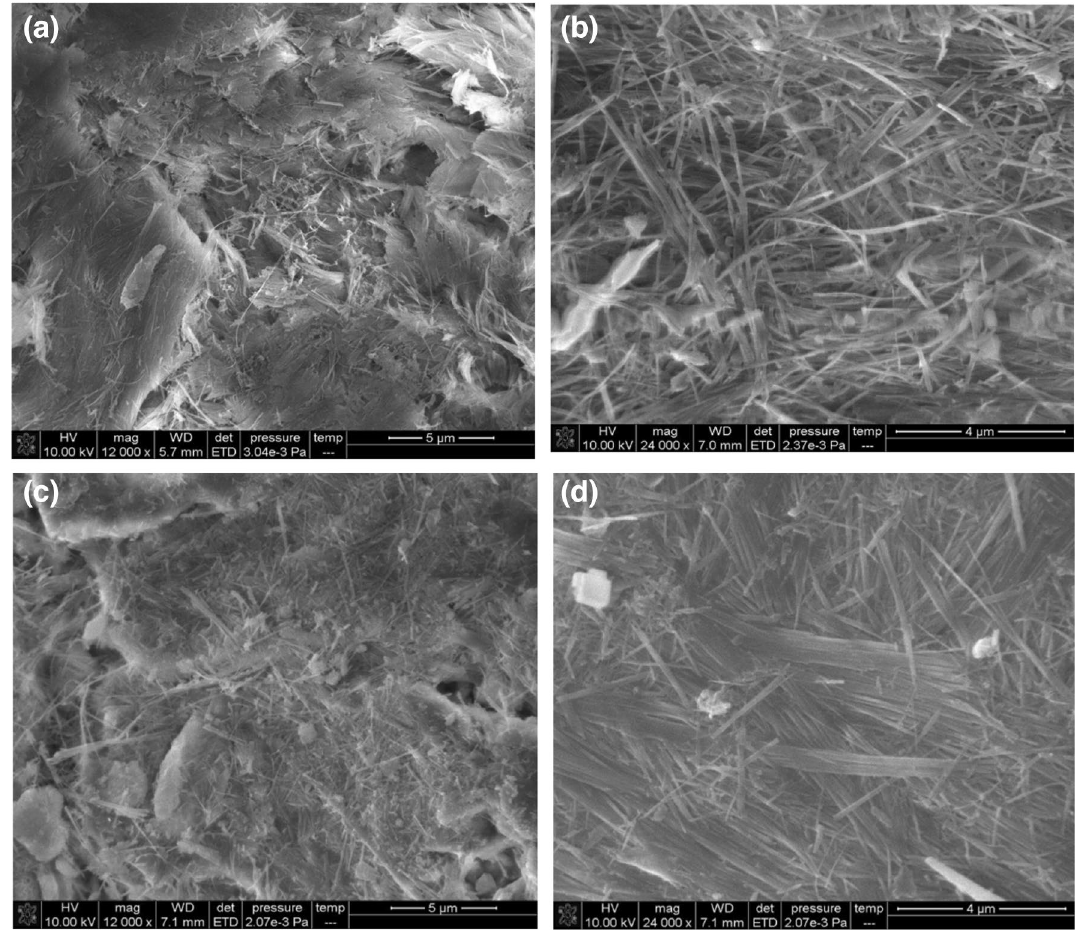
Figure 2. SEM images of sepiolite ( a ), NiO/sepiolite ( b ), regenerated sepiolite ( c ) and regenerated NiO/sepiolite ( d